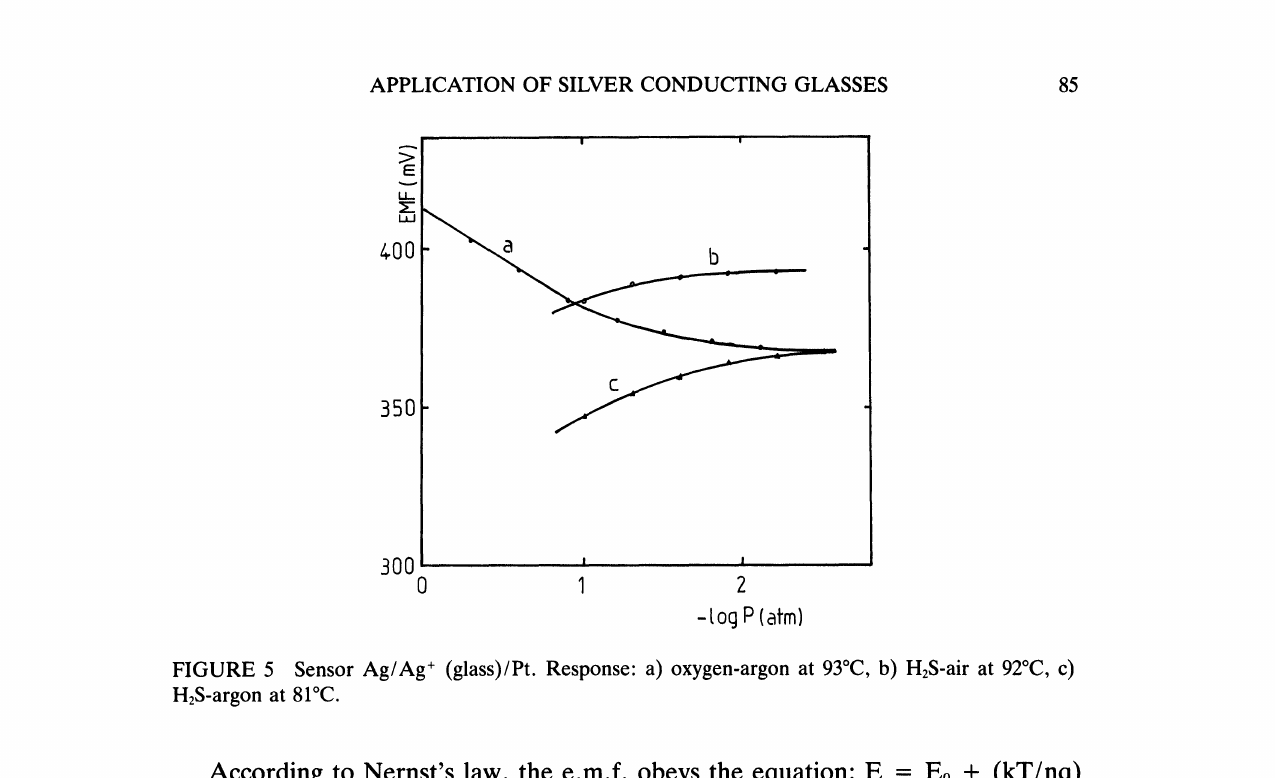
FIGURE 5 Sensor Ag/Ag (glass)/Pt. Response: a) oxygen-argon at 93C, b) H2S-air at 92C, c) H2S-argon at 81C.